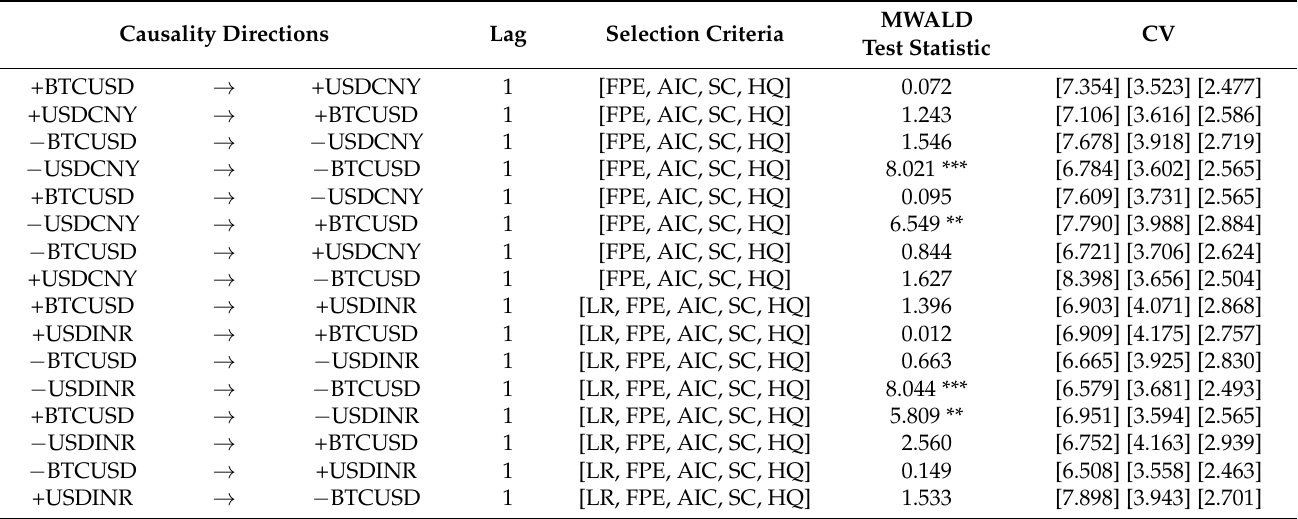
Table 4. Hacker-Hatemi Asymmetric Modified Wald Test.